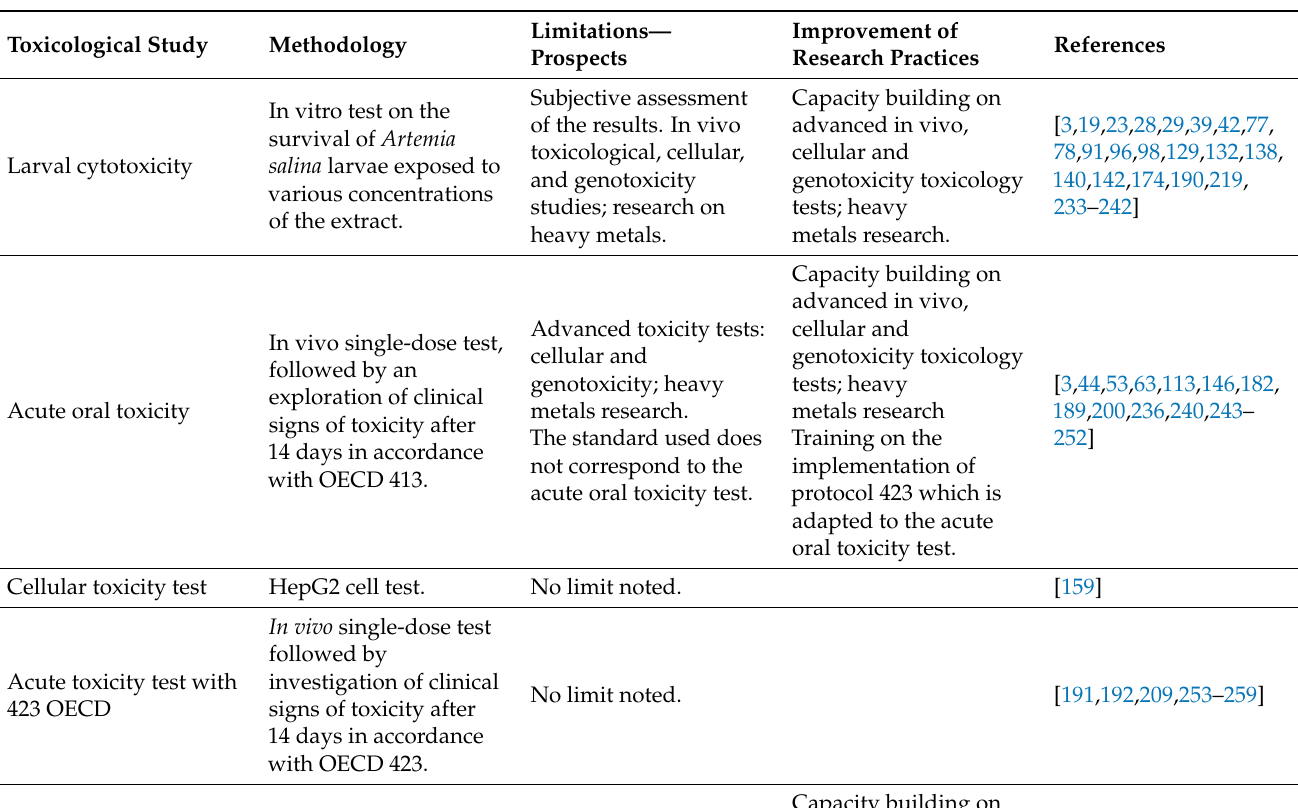
Table 2. Methodologies of studies of toxicity tests: limitations and proposals for improvement of research